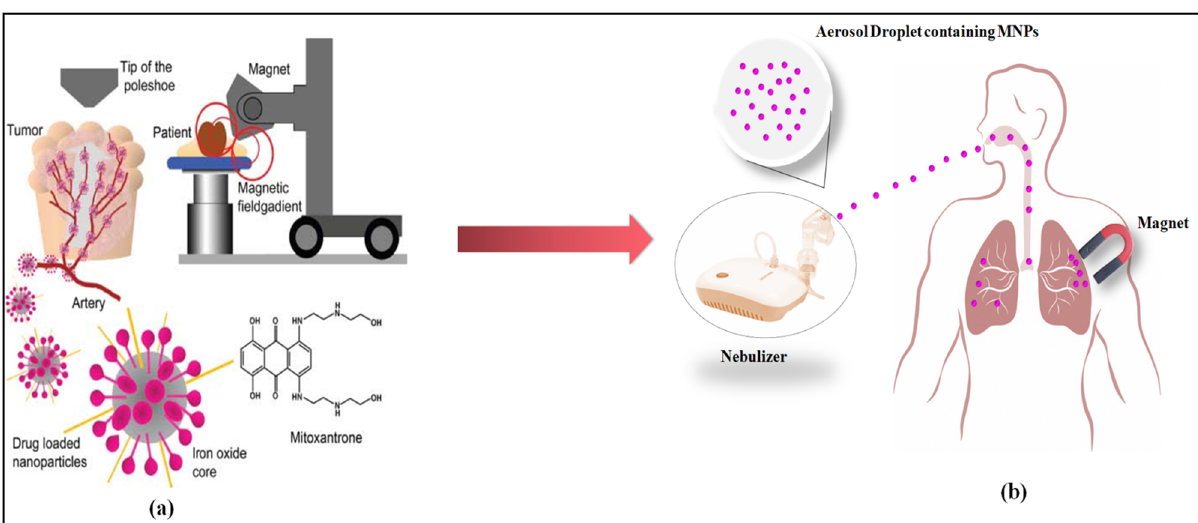
Figure 1: ( a ) MDT with intravascular administration. MNPs bind e ff ectively to an anticancer drug that is directly injected into the tumor - feeding blood vessel of the patient. It is then concentrated in the target tumor site by an external magnetic fi eld. Reprinted from ref. [ 6 ] by Creative Commons License. ( b ) Targeted delivery of magnetic aerosol droplets. Reprinted from ref. [ 74 ] by Creative Commons